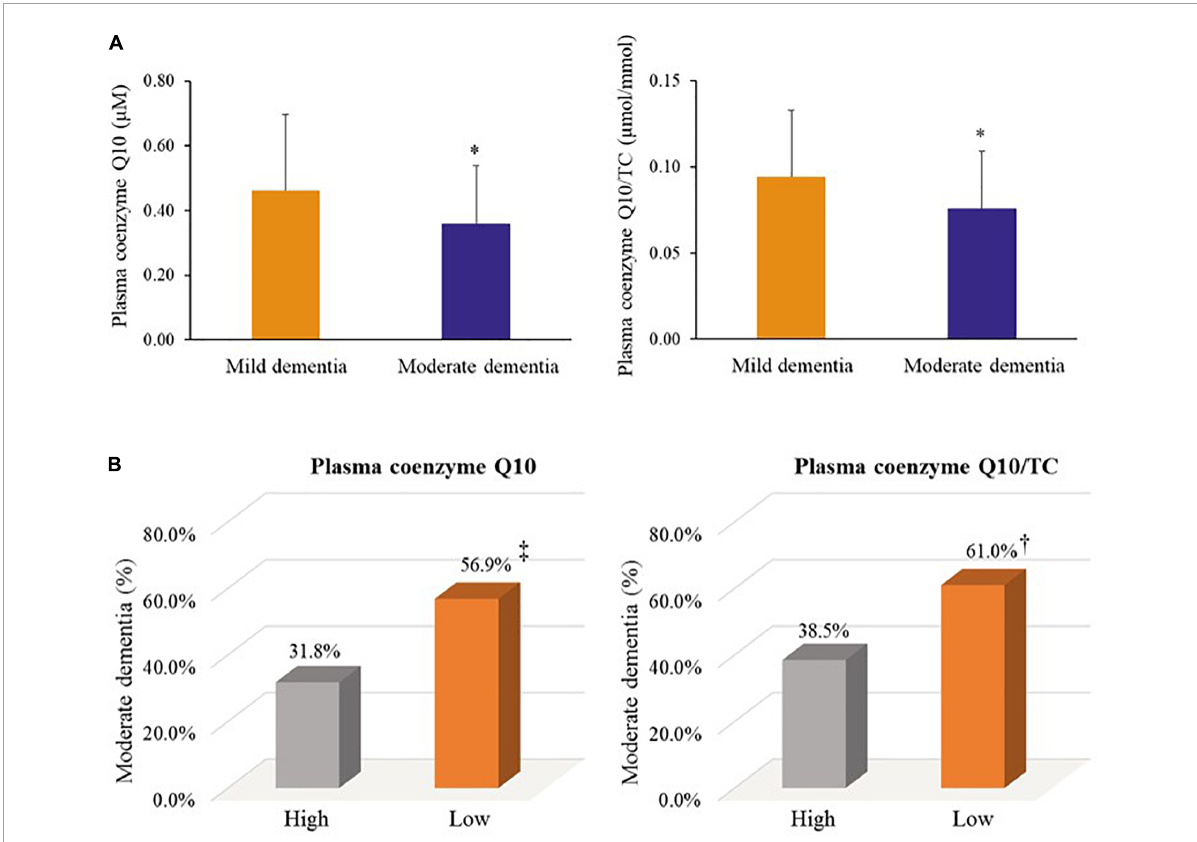
FIGURE5 Coenzyme Q10 status and dementia progression. (A) Coenzyme Q10 status in patients with mild and moderate dementia. (B) The proportion of moderate dementia by coenzyme Q10 status. Mild dementia: the score of MMSE > 20; Moderate dementia: the score of MMSE ≤ 20. Low plasma coenzyme Q10: plasma coenzyme Q10 < 0.5 µ M; High plasma coenzyme Q10: plasma coenzyme Q10 ≥ 0.5 µ M. Low plasma coenzyme Q10/TC: plasma coenzyme Q10/TC < median value; High plasma coenzyme Q10/TC: plasma coenzyme Q10/TC ≥ median value. MMSE, mini mental state examination; TC, total cholesterol; WBC, white blood cell. ∗ , p < 0.05; † , p = 0.07; ‡ , p =